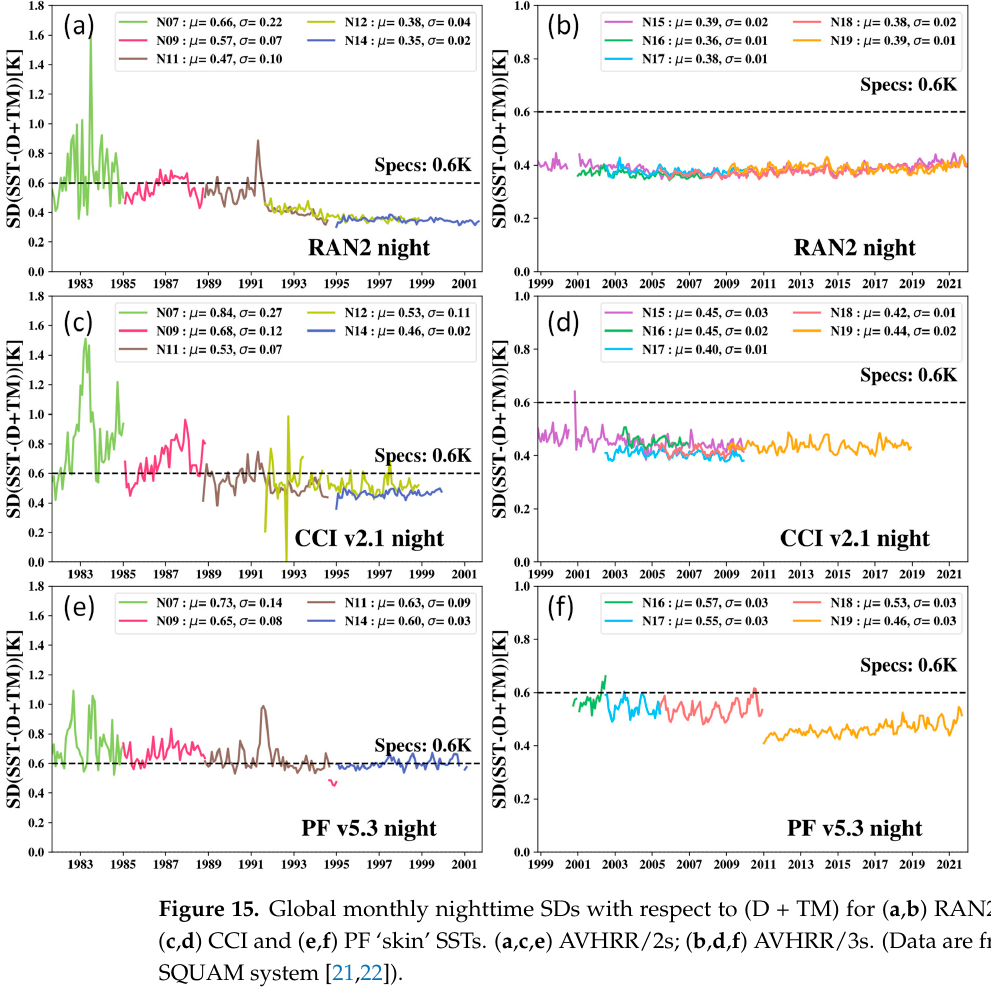
Figure 15. Global monthly nighttime SDs with respect to (D + TM) for ( a , b ) RAN2 ‘subskin’ SST, ( c , d ) CCI and ( e , f ) PF ‘skin’ SSTs. ( a , c , e ) AVHRR/2s; ( b , d , f ) AVHRR/3s. (Data are from the NOAA SQUAM system [21,22].)